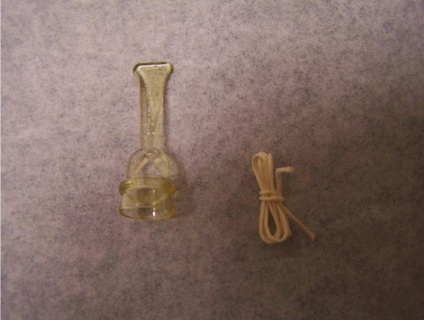
FIGURE 3: The Plastibell is placed over the glans and a suture is secured over the skin. After several days, the skin will slough and the Plastibell falls off.